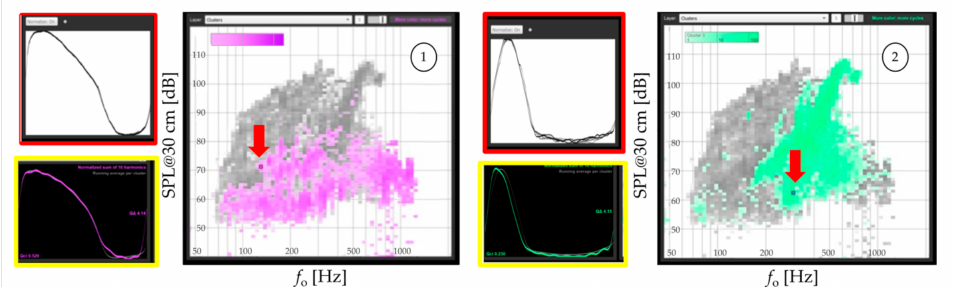
Figure 11. Examples of voice maps displayed by FonaDyn software for (1) firm and (2) breathy phonation, produced by a male singer while observing the EGG waveshape (red boxes) in real-time and trying to match the EGG waveshape model of the intended phonation type (yellow boxes). The result is also presented in real-time as an individual cell in the voice map (red arrows). Note: SPL, sound pressure level; f o , fundamental